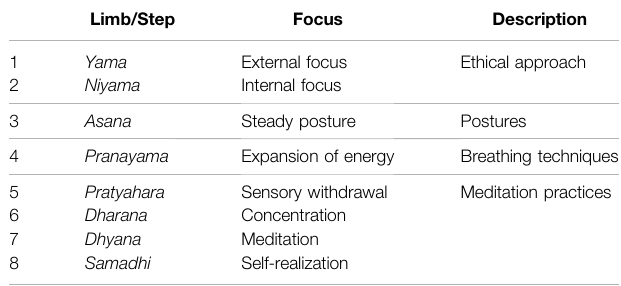
TABLE 1 | Steps/Limbs in the system of yoga